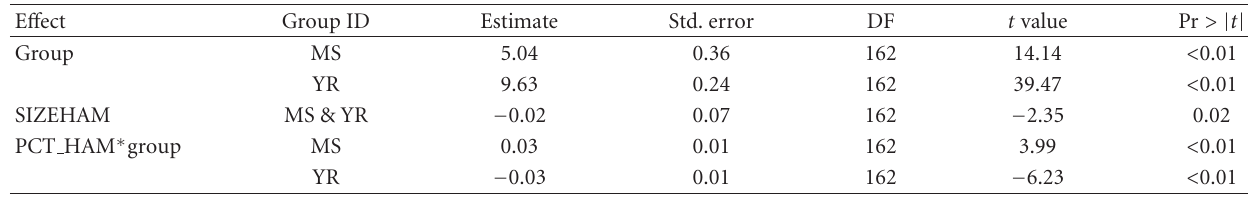
Table 3: Heterogeneous slopes model results used to evaluate the influence of site and landscape variables on species richness, species diversity (using Shannon-Wiener index values), and the e ff ective number of species (converted from Shannon-Wiener Index values; [26]) for migratory (MS) and resident (YR) birds, in the Florida Keys during March–May 2004 and 2005. Only the final model solutions and respective Akaike information criterion (AIC) values are presented. Model variables are defined in Table